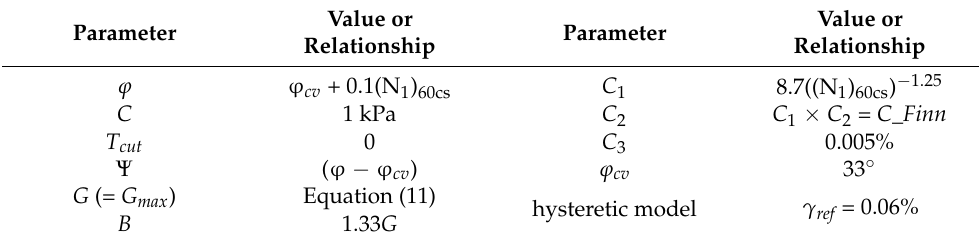
Table 4. Calibrated parameters of the Finn model–Byrne formulation in FLAC.